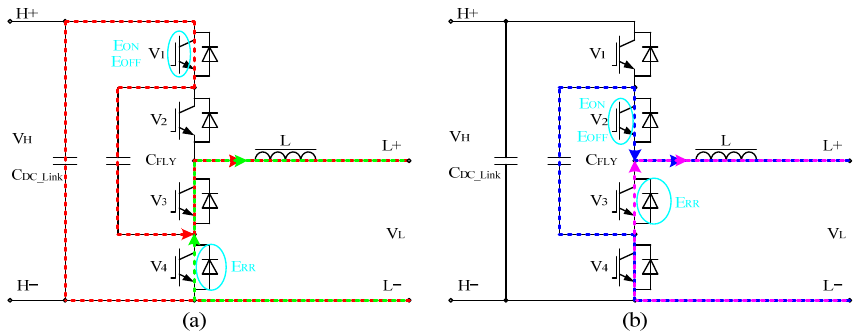
Figure 3. Commutation paths of FC ‐ 3L ‐ BDC. ( a ) Buck mode, D < 0.5 (V 1 switching). ( b ) Buck mode, D < 0.5 (V 2 switching).